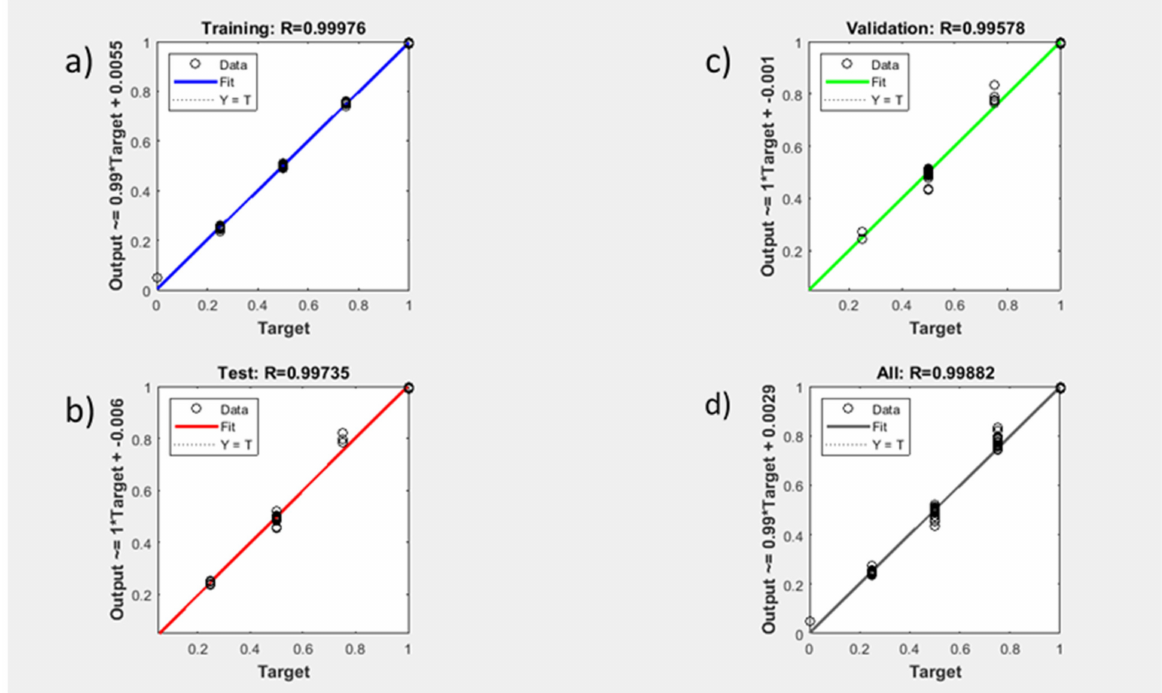
Figure 4. Neural Network regression results of 268 patients. ( a ) The train success of the system using 160 patients (99.9%). ( b ) The test success of the system using 54 patient (99.7%). ( c ) The validation success of the system using remain 54 patients (~99.6%). ( d ) The overall success rate of the system (~99.9%). X-axis represented as output explain regressions data. Y-axis represented as target meaning success ratio between